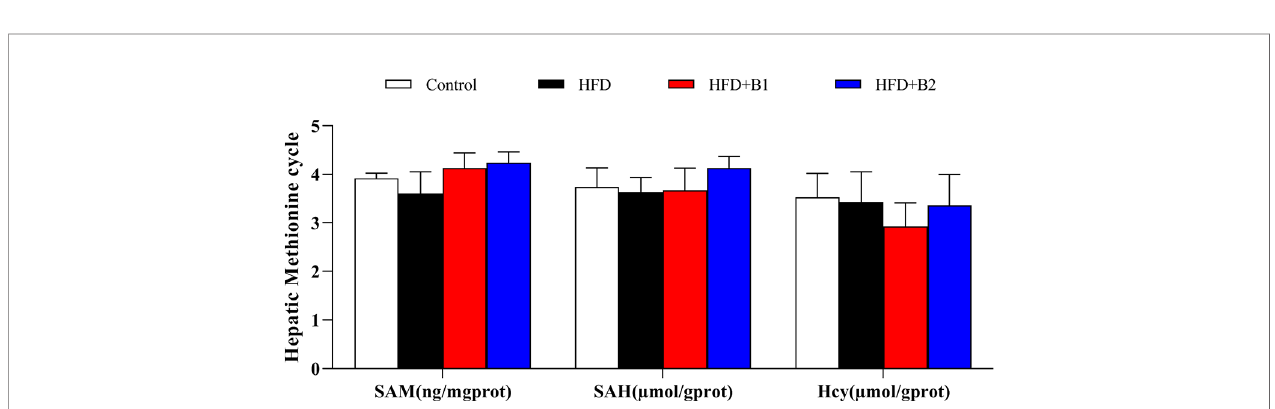
FIGURE 5 | Hepatic methionine metabolic pathway markers of juvenile black seabream ( Acanthopagrus schlegelii ) fed the experimental diets [Control: 11% crude lipid; HFD, high-fat diet; HFD+B1, HFD +betaine (10g/kg); HFD+B2, HFD + betaine (20 g/kg)] for 8 weeks. SAM, S-adenosylmethionine; SAH, S- adenosylhomocysteine; Hcy, homocysteine. Values are means (n=3) with standard errors represented by vertical